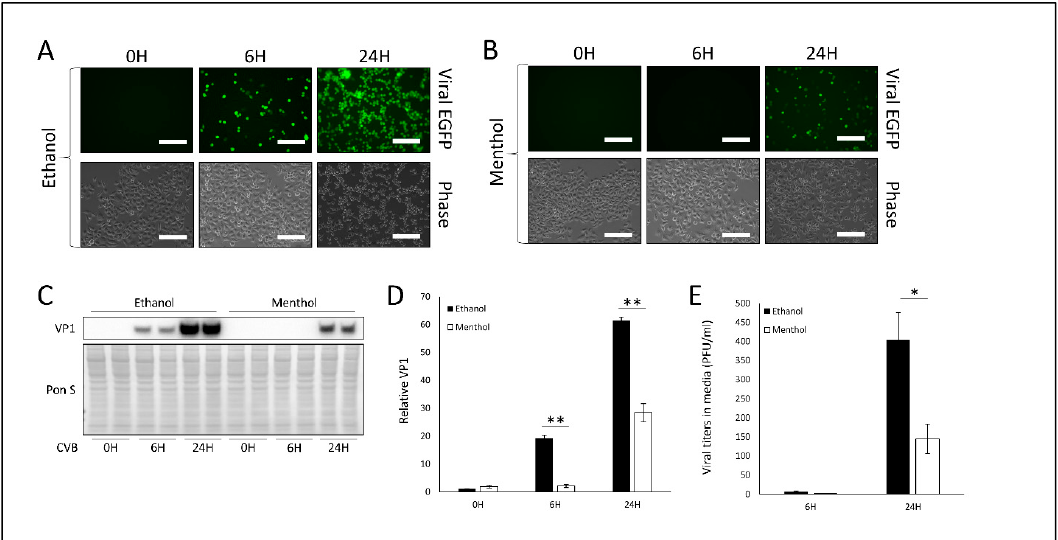
Figure 3. Treatment with TRPM8 agonist menthol impairs CVB infection- HeLa cells were treated with 1 mM menthol or equivalent volume ethanol for 1 h and subsequently infected with EGFP-CVB at MOI 0.1 for 24 h. Fluorescence microscopy compares viral EGFP expression between cells treated with ( A ) ethanol or ( B ) menthol. Phase contrast images are shown below respective fluorescence image fields. Scale bars represent 150 µm. ( C ) Western blot on cell lysates from A and B detecting VP1 viral capsid protein. Ponceau S is shown below. ( D ) Densitometric quantification of western blot in C. (** p < 0.01; Student’s t-test, n = 3). ( E ) Plaque assay quantification of infectious virus in media from cells in A and B. (* p < 0.05; Student’s t-test, n = 3).